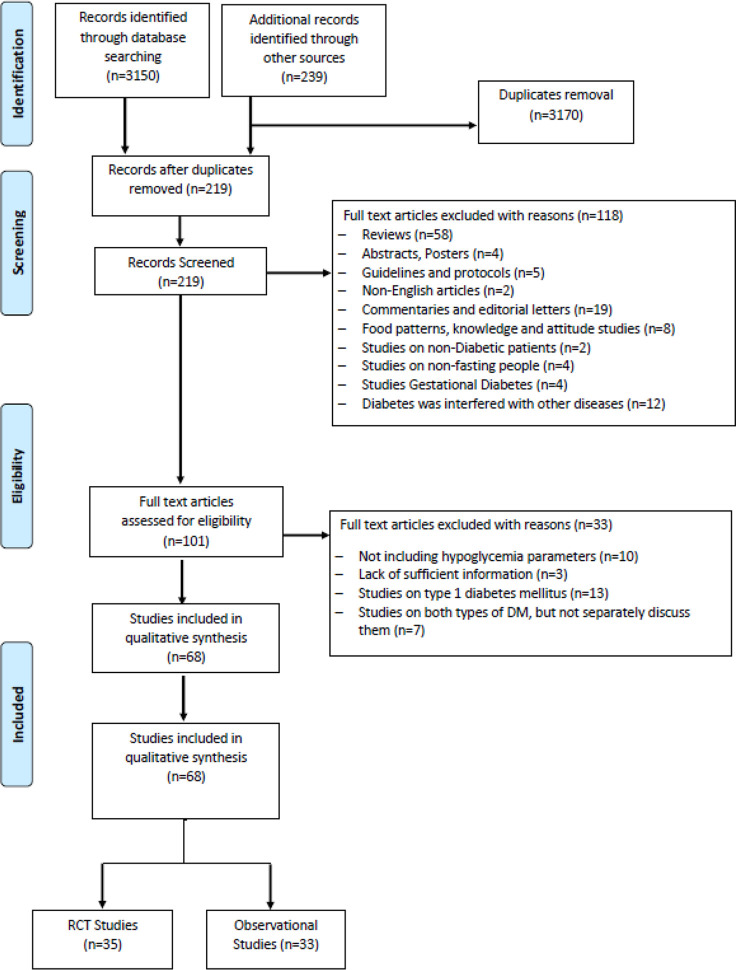
Flow chart for study selection.